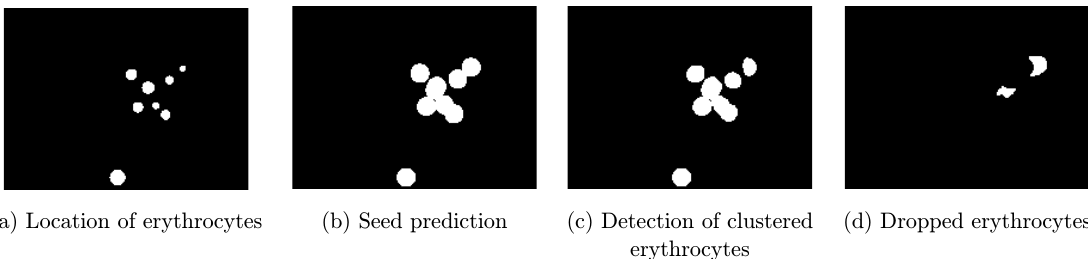
Fig. 6. Processing of overlapping clusters (2).